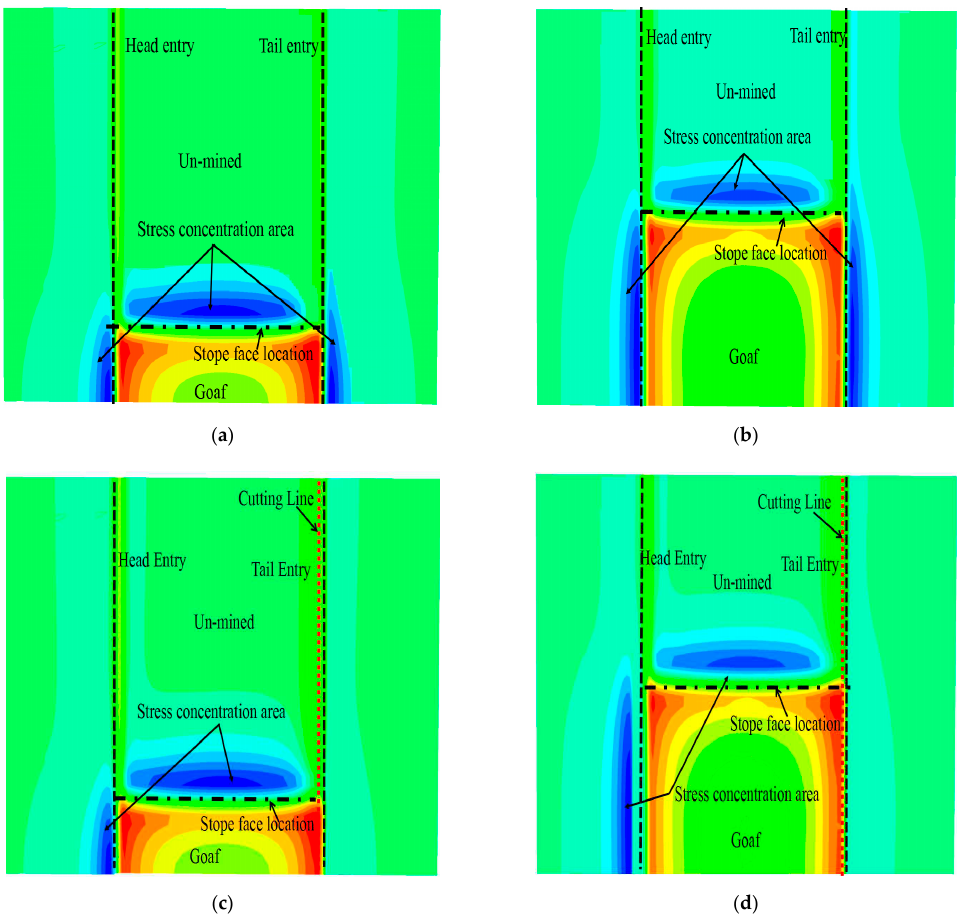
Figure 16. The plane development of the abutment stress distribution: ( a ) The stress distribution of 40m exploitation without roof cutting. ( b ) The stress distribution of 80m exploitation without roof cutting. ( c ) The stress distribution of 40m exploitation with roof cutting. ( d ) The stress distribution of 80m exploitation with roof cutting.